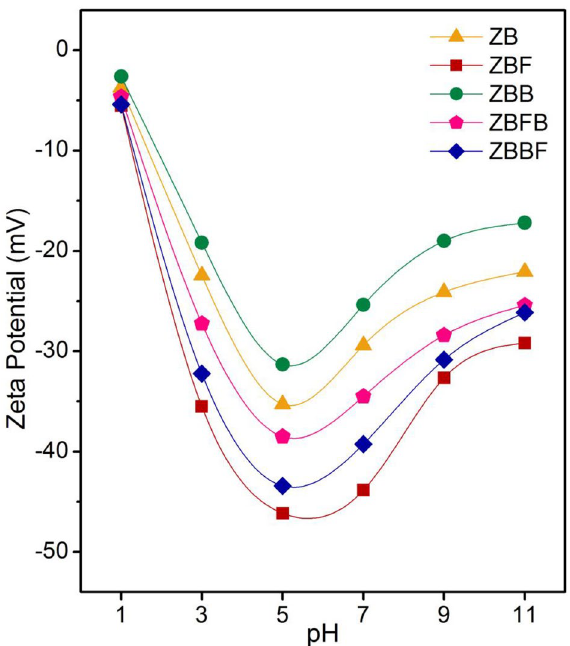
Figure 6. Zeta potentials of zeolite A sugarcane bagasse fly ash powder (ZB), zeolite A sugarcane bagasse fly ash powder mixed iron(III) oxide-hydroxide (ZBF), zeolite A sugarcane bagasse fly ash beads (ZBB), zeolite A sugarcane bagasse fly ash powder mixed iron(III) oxide-hydroxide beads (ZBFB), and zeolite A sugarcane bagasse fly ash beads coated iron(III) oxide-hydroxide (ZBBF) under different pH